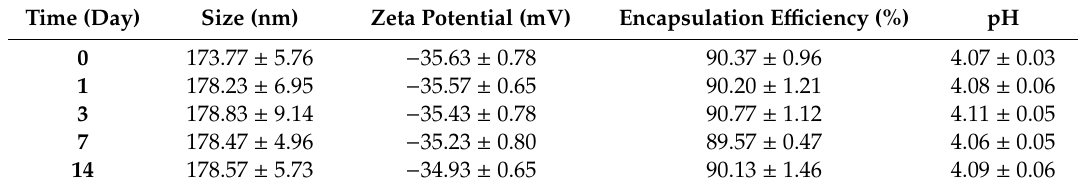
Table 5. Stability profiles on physicochemical characteristics of nanoemulsion (at 25 °C, n = 3, mean ± SD). Time (Day) Size (nm) Zeta Potential (mV) Encapsulation E ffi ciency (%)